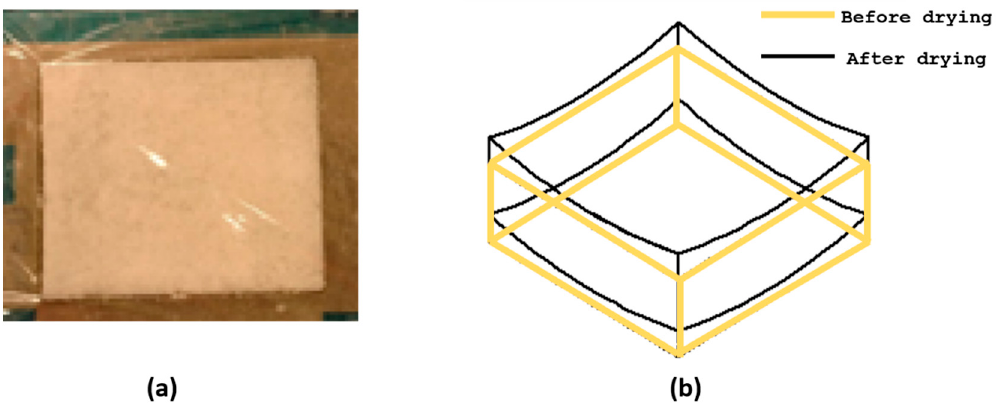
Figure 1. Original mold design, MDP00, and the resultant product ( a ) Top and bottom surface covered by porous transparent film ( b ) Observed synclastic form of curved aerogel sheet.